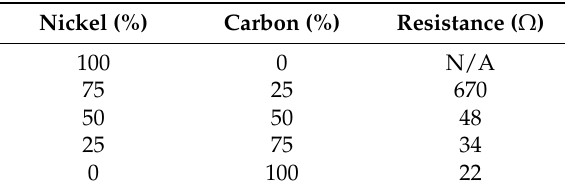
Table 1. Resistances of DSPNCE with Ni paste ratios.